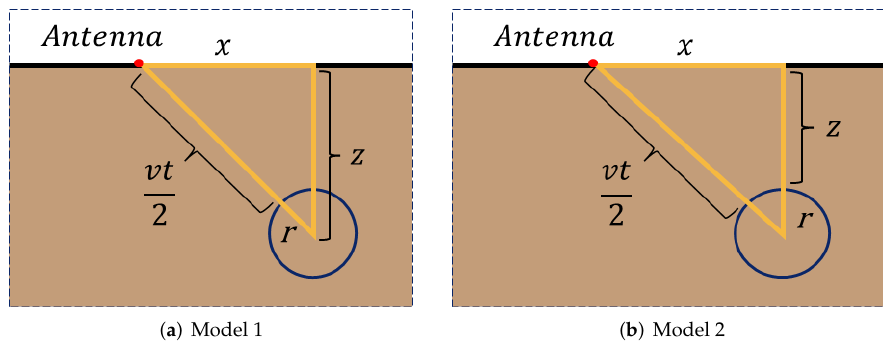
Figure 6. Physical model with different definition of